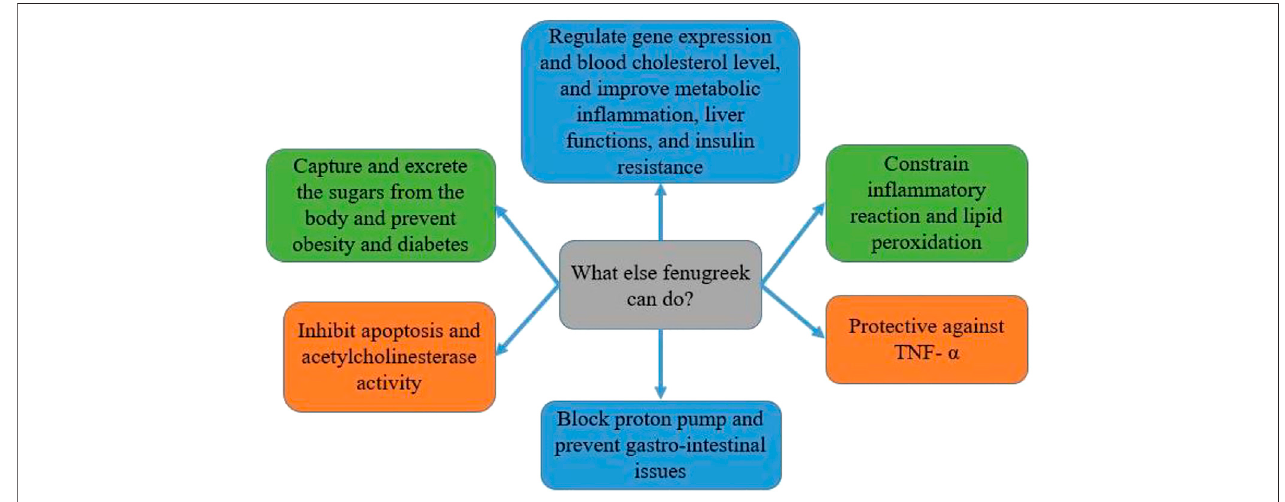
FIGURE 10 | Health bene fi ts and anticancer properties of fenugreek.